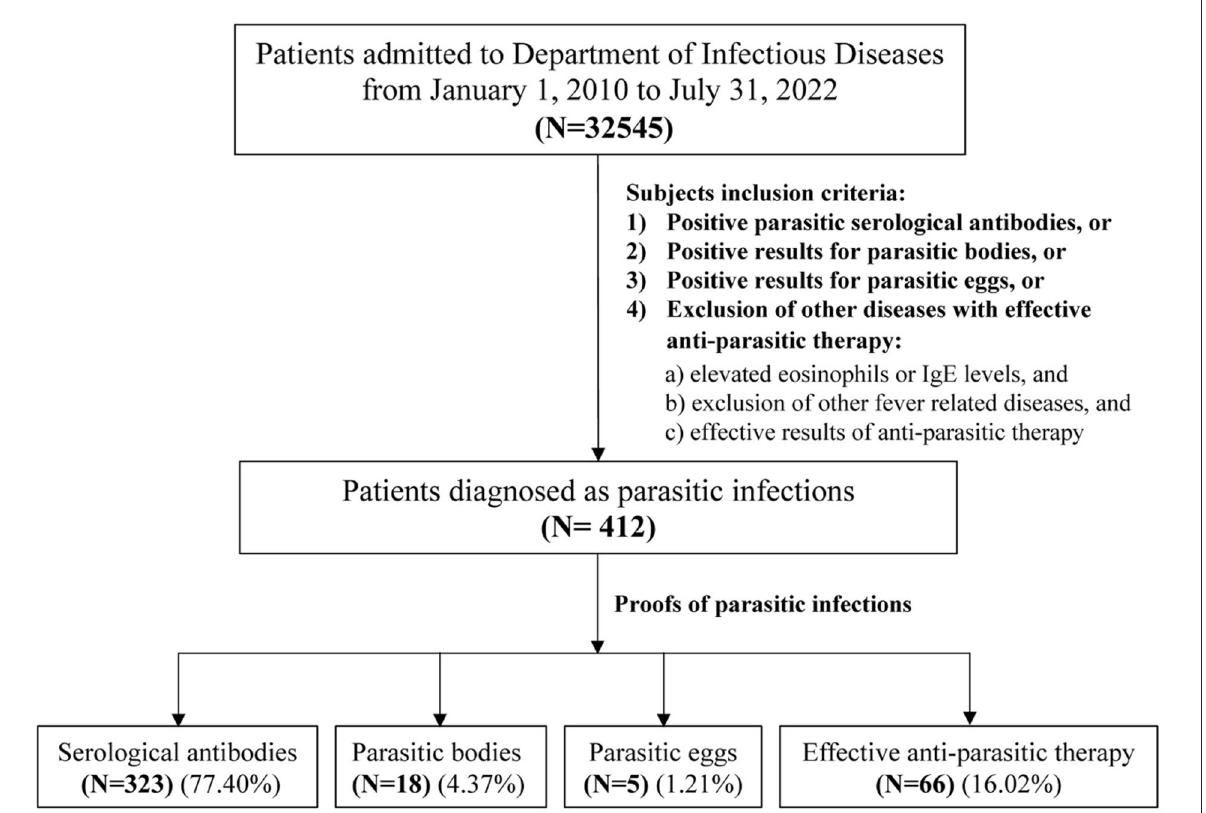
FIGURE1 Flowchart of the subjects’ inclusion criteria. Among total of 32545 patients admitted to the Department of Infectious Diseases of Ruijin hospital from January 1, 2010 to July 31, 2022, there were only 412 patients were parasitic infections. A small number of patients with uncertain parasitic infection (16.02%) were diagnosed by the exclusion of other diseases with effective anti-parasitic therapy, and all the following three criteria should be met in this group: (1) elevated eosinophils or IgE levels; (2) exclusion of other fever-related diseases; and (3) effective results of anti-parasitic